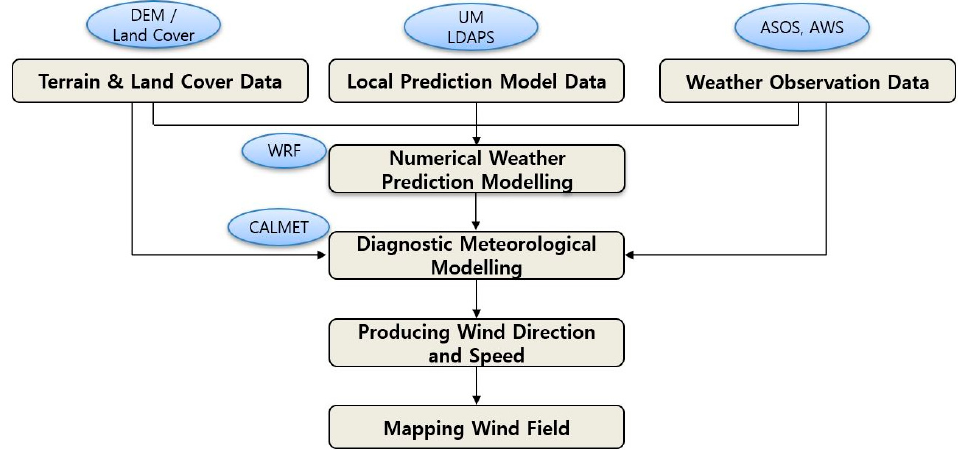
Figure 1. Mapping process of wind field data using numerical weather predictions and diagnos- tic meteorological models: DEM, digital elevation model; UM, unified model; LDAPS, local data assimilation, and prediction system; ASOS, automated synoptic observation system; AWS, auto- matic weather station; WRF, weather research and forecasting model (one of the numerical weather prediction models employed); CALMET, California meteorological model (a type of diagnostic meteorological